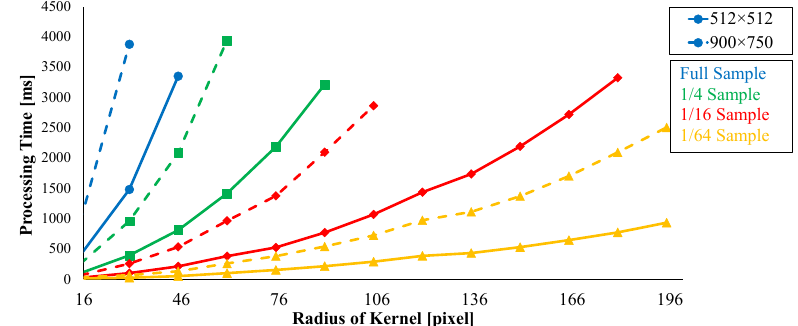
Figure 21. Processing time for loop vectorization with respect to the kernel radius of FIR filtering. There are 2 × 4 lines, and their combinations represent image resolution (512 × 512 and 900 × 750) and kernel subsampling ratio (full, 1/4, and